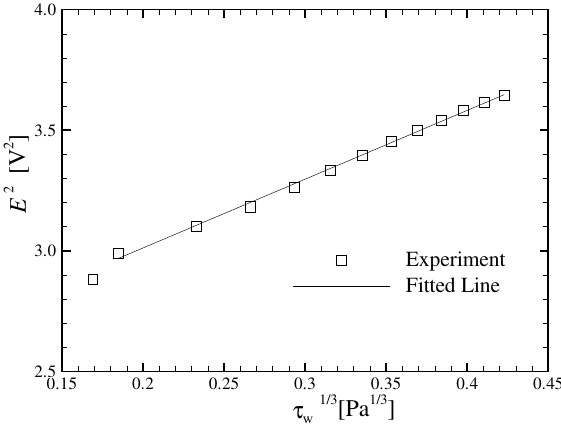
1 3 w versus E 2